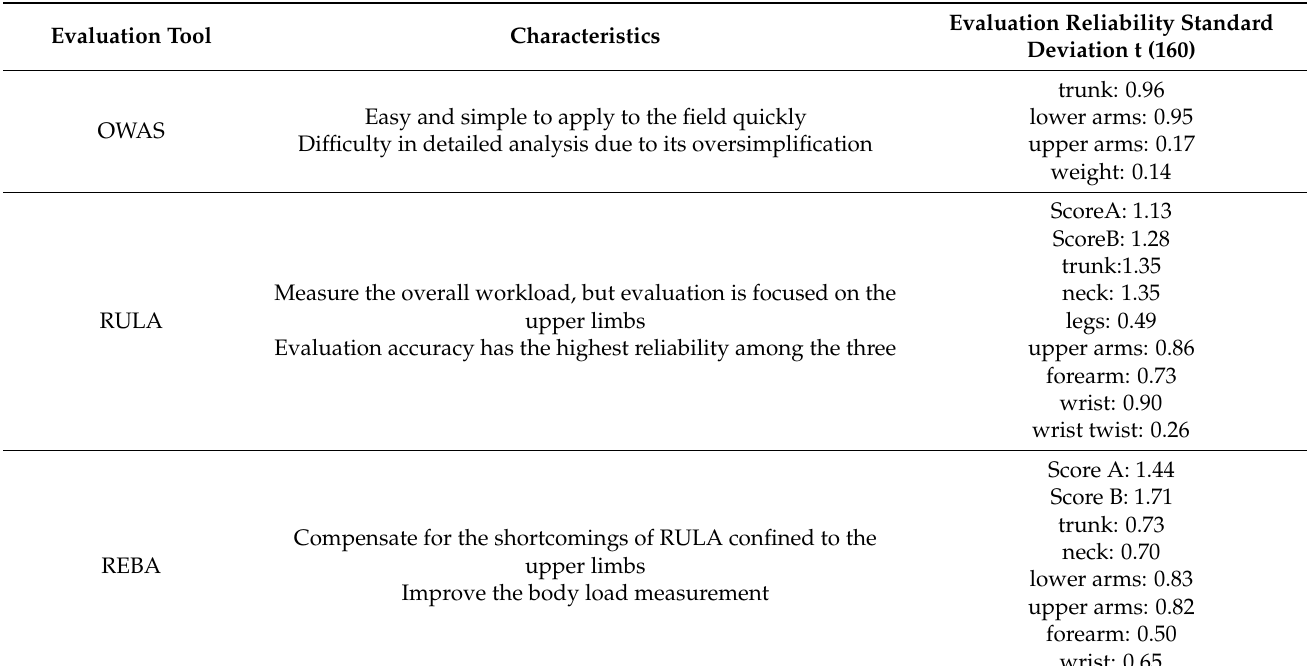
Table 1. Characteristics and the reliability of each evaluation tool.